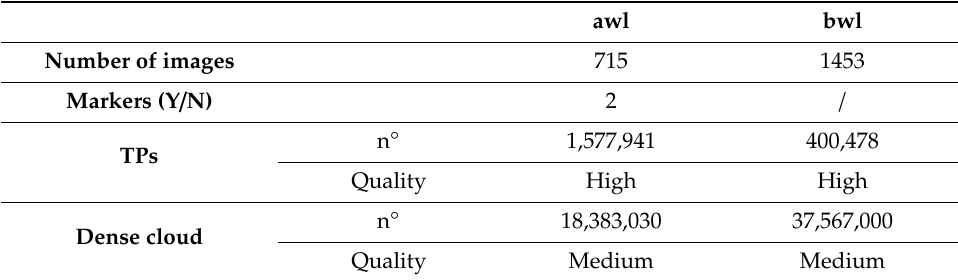
Table 6. Elaboration parameters of the plunging cliffs at Premantura.